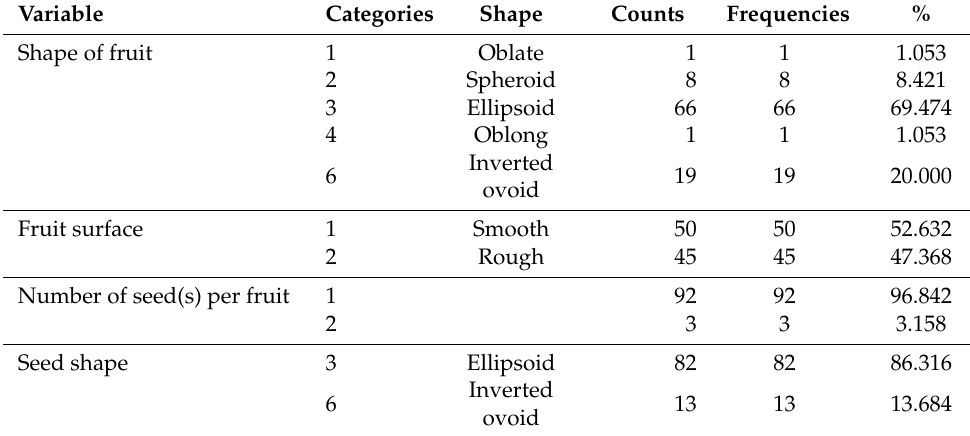
Table 6. Qualitative analysis of fruit